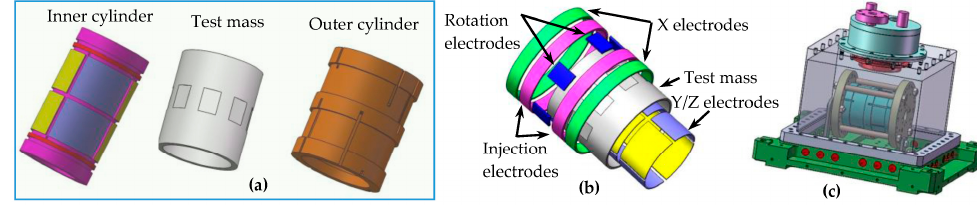
Figure 11. The sensor unit configuration: ( a ) Test mass and inner/outer cylinders; ( b ) Exploded view of various electrodes; ( c ) The assembled senor unit operated inside a vacuum chamber.